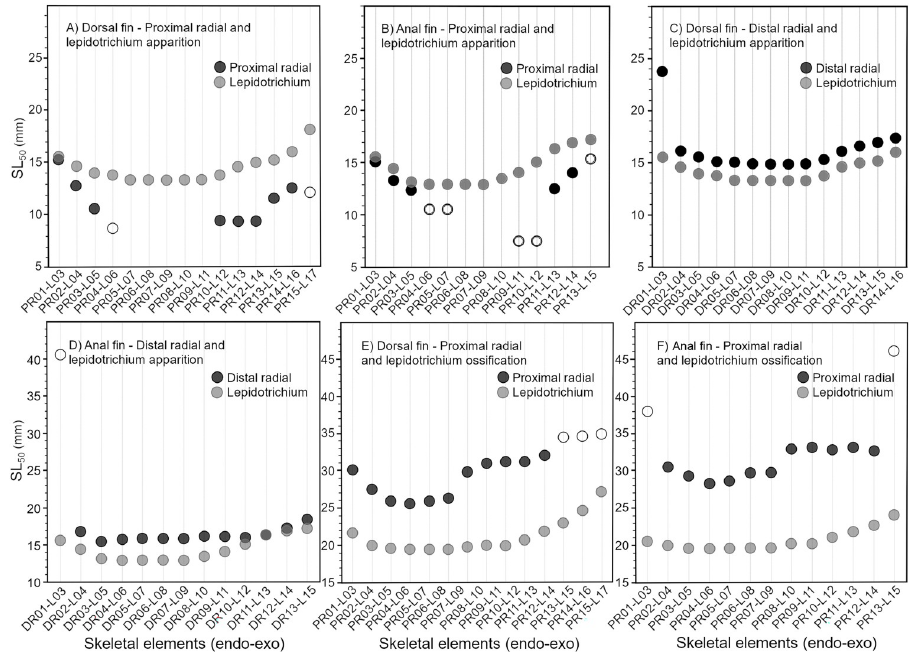
Fig 4. Comparisons between developmental sequences (apparition and ossification) of the endoskeleton (radials; black) and exoskeleton (lepidotrichia; grey) of the dorsal (A, C, E) and anal fins (B, D, F) of the rainbow trout ( Oncorhynchus mykiss ). Skeletal elements are ordered from anterior to posterior. Filled and empty symbols represent significant and non-significant results for SL50